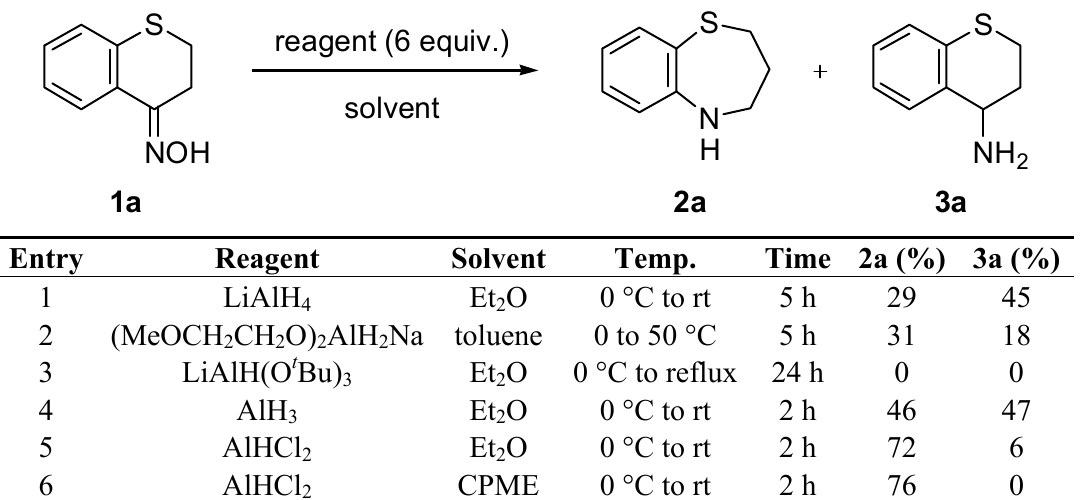
Table 1. Rearrangement of oxime with various